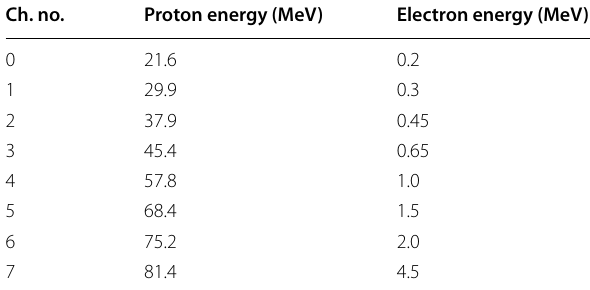
Table 2 Energies of proton and electron channels Ch. no.